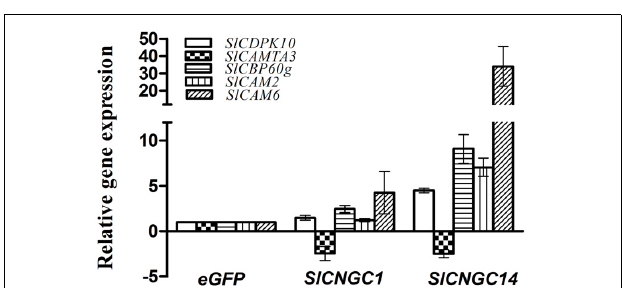
FIGURE 5 | Silencing of SlCNGC1 and SlCNGC14 altered expression of defense-related Ca 2 + signaling genes. Expression of defense-related Ca 2 + signaling genes SlCAM2 , SlCAM6 , SlCDPK10 , SlCAMTA3, and SlCBP60g were examined for SlCNGC1 -, SlCNGC14 -silenced plants relative to the eGFP non-silenced control plants after inoculation with Xoc at 4 hpi by qRT-PCR with 18s rDNA gene serving as a loading control gene. Data represent the mean ± SE of three independent